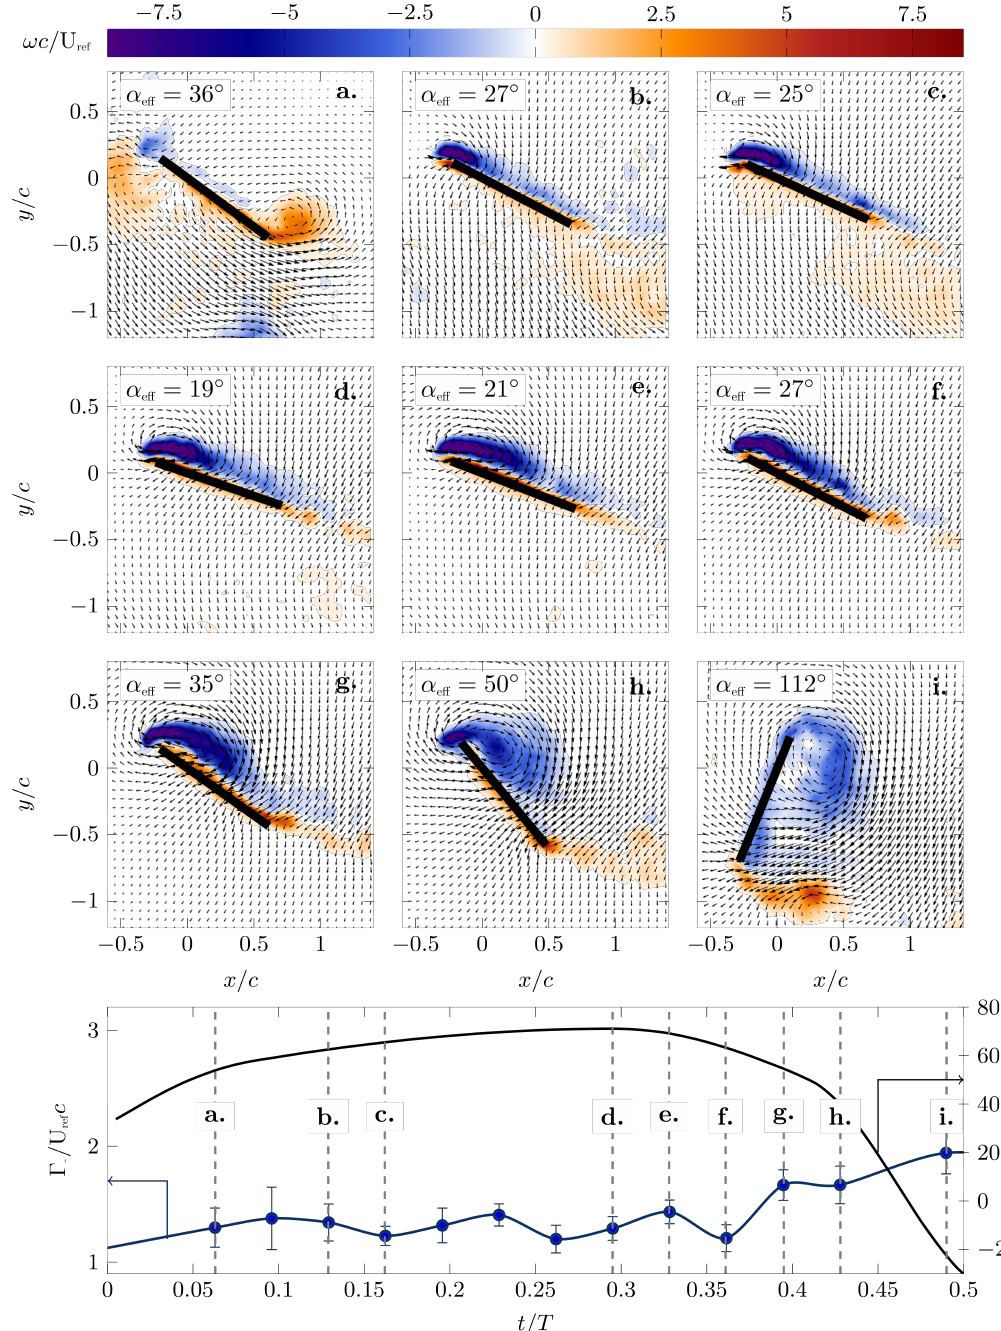
Figure 9. Velocity and vorticity fields at selected phases within the flapping cycle for the final generation of the efficiency optimization of the pitch